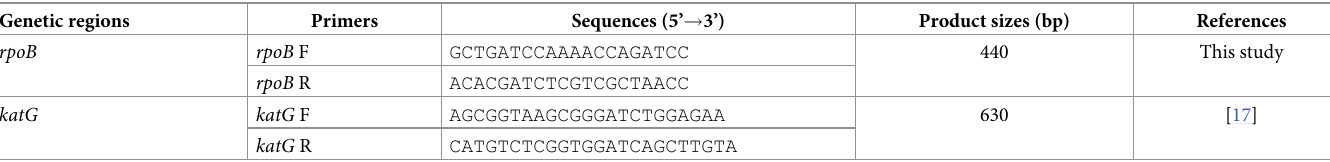
Table 1. Primer sequences for PCR and DNA sequencing. Genetic